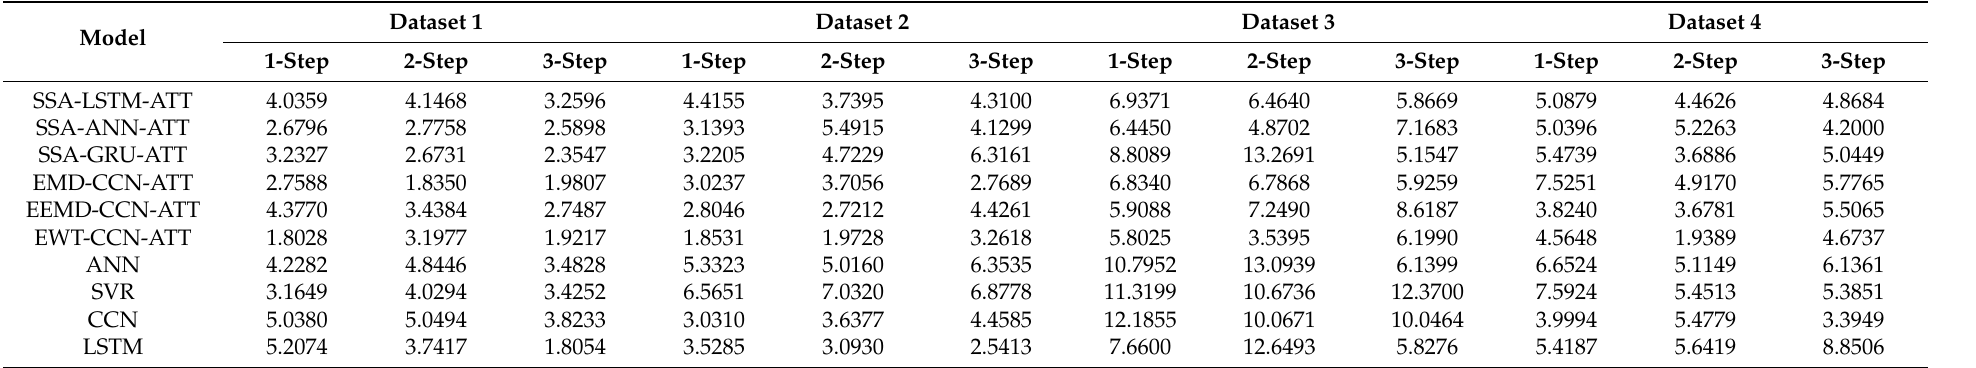
Table 8. DM test result of different models in four datasets.